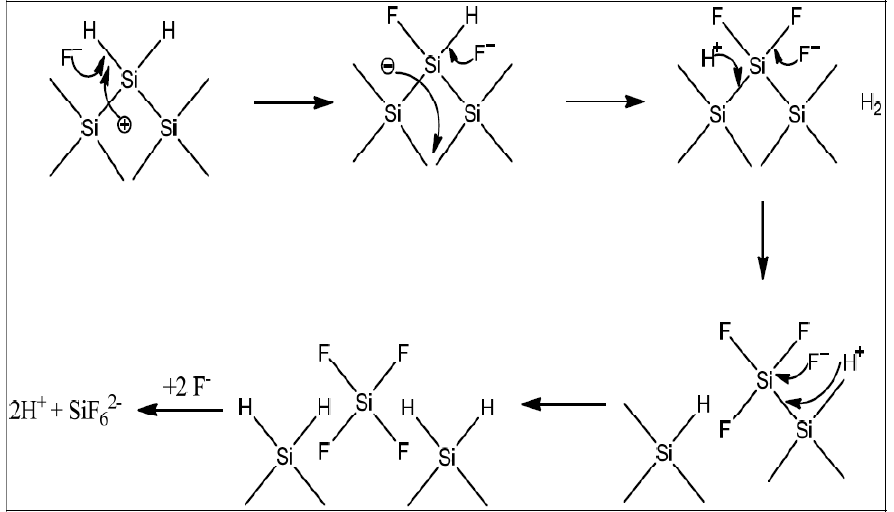
Fig. 3. Mechanism of silicon dissolution by HF during electrochemical